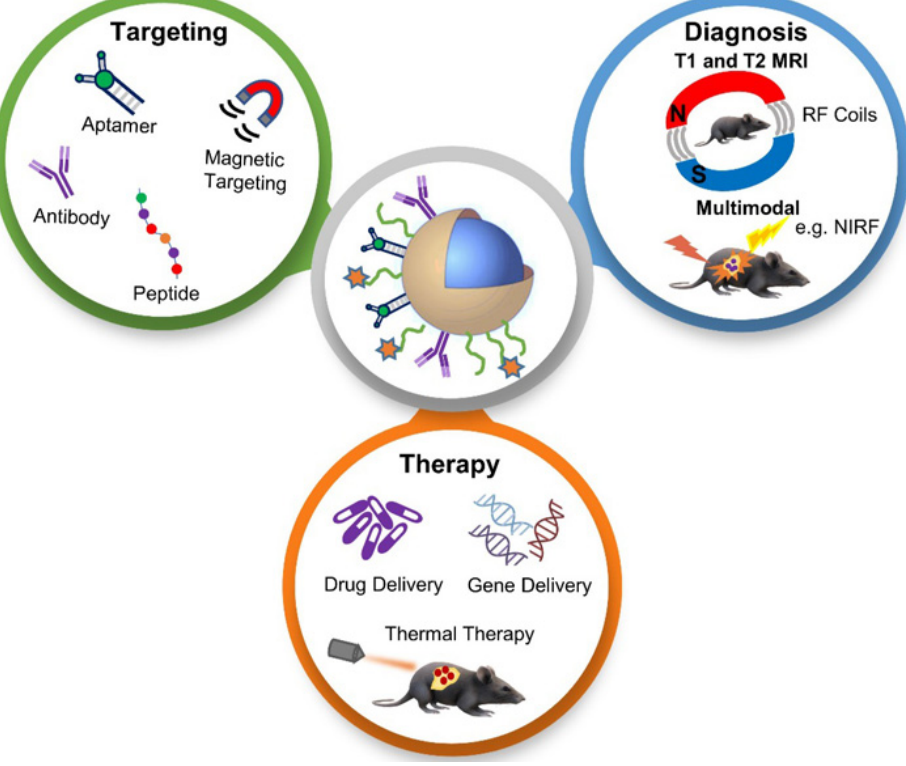
Figure 4. Schematic diagram showing applications of functionalized magnetic NPs in MRI-based diagnosis and anticancer therapy. Reproduced with permission from [55]. Copyright Anani et al.